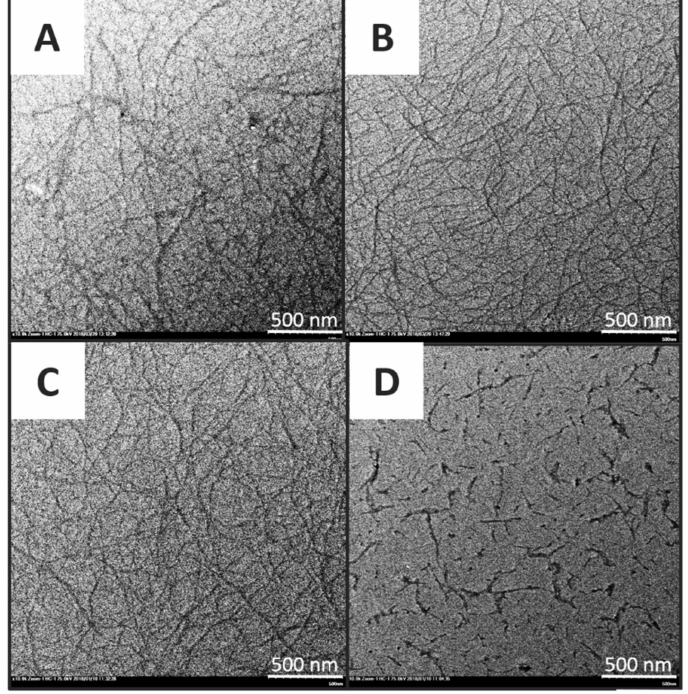
Figure 1. TEM micrograph of ( A ) chitin nanofibers after 1 h ultrasonication; ( B ) after 2 h ultrasonication; ( C ) deacetylated chitin nanofibers; and ( D ) chitin nanocrystals from squid